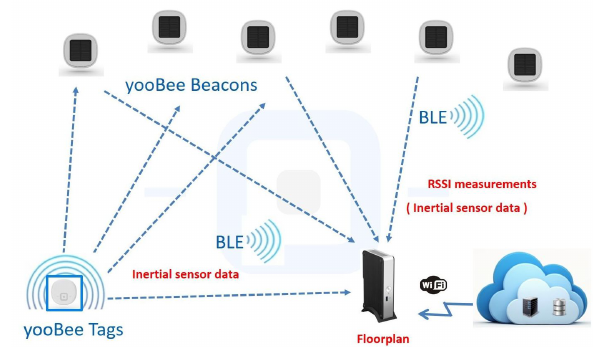
Figure 1. The communication between tags, beacons, basestation and the Cloud server. Source: BlooLoc